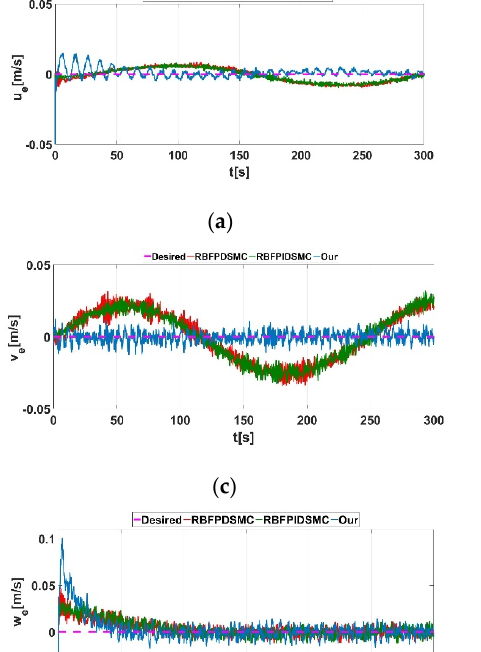
; ( c ) 𝑦 ; ( d ) 𝜃 𝑒 ; ( e ) z 𝑒 ; ( f ) 𝜓 . 𝑒 𝑒 𝑒 , 𝑒